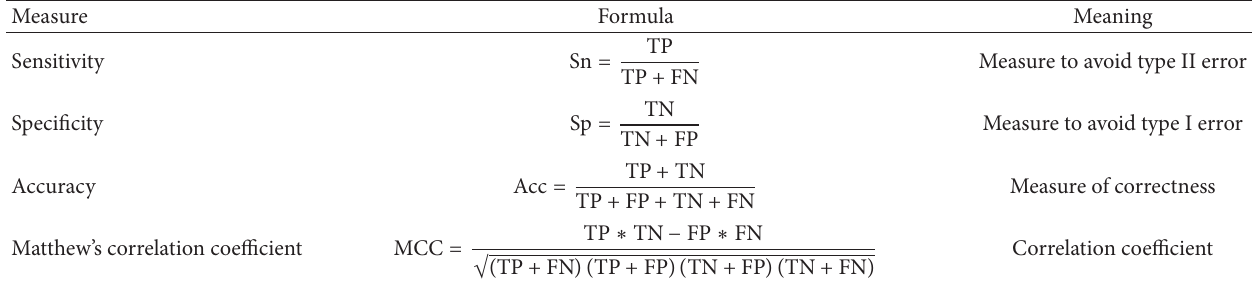
Table 4: Performance measures for random forest from SVM-Prot